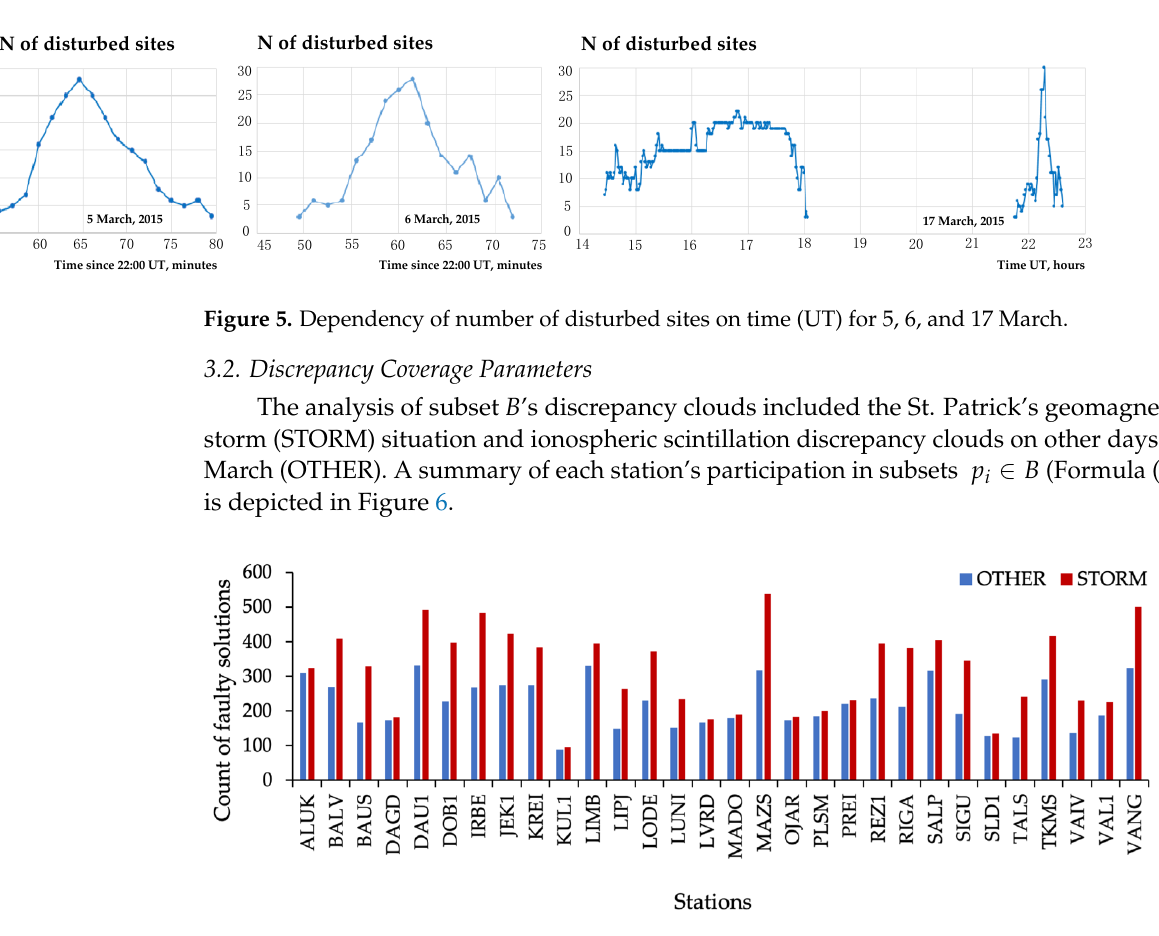
Figure 8. Standard deviation for ‘calm’ days (STD C) and for storm day on 17 March (STD S). According to Figure 8, stations IRBE, RIGA, and VANG had the largest positioning errors during the geomagnetic storm. The stations LUNI, VAIV, KREI, SALP, and JEK1 were also erroneous. Stations LUNI, VANG, RIGA, and LVRD were most affected on ‘calm’ days. Pearson ’ s correlation coefficients (Equation (1), Table S6) were obtained in relation to discrepancies and ROTI in peak subsets 𝑝 𝑖 ∊ 𝐵 . All correlation coefficients were less than 0.4 or below zero (Figure 9). This meant that the correlation of discrepancies with ROTI was weak. There was no reason to compute the relationship between discrepancies and TEC because only one TEC max value for the area of Latvia (Table S3) was introduced in the computation with Bernese GNSS Software v5.2.